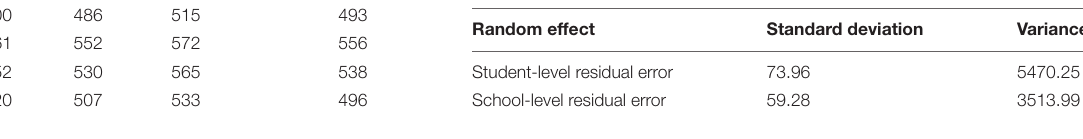
TABLE 4 | The analysis result of the null model (Model